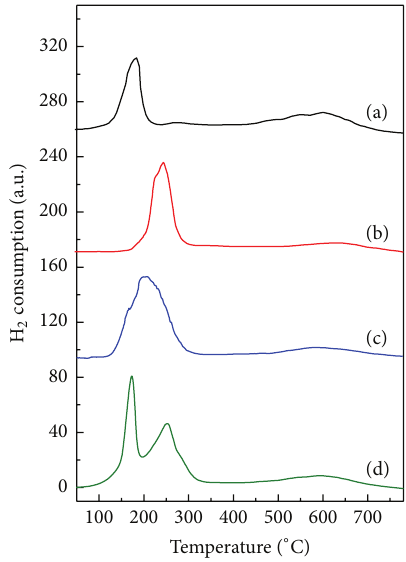
Figure 1: TPR profiles for (a) Pt/C, (b) Ru/C, (c) Pt-Ru co /C, and (d) Pt-Ru se